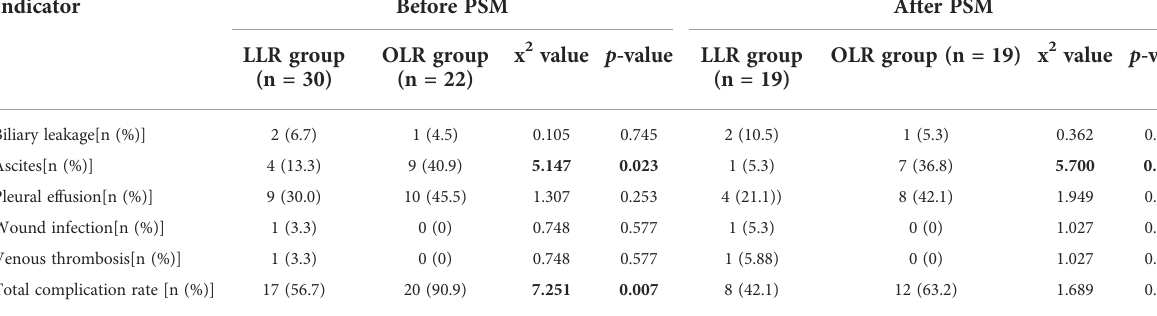
TABLE 3 Comparison of postoperative complications between the two groups before and after PSM.